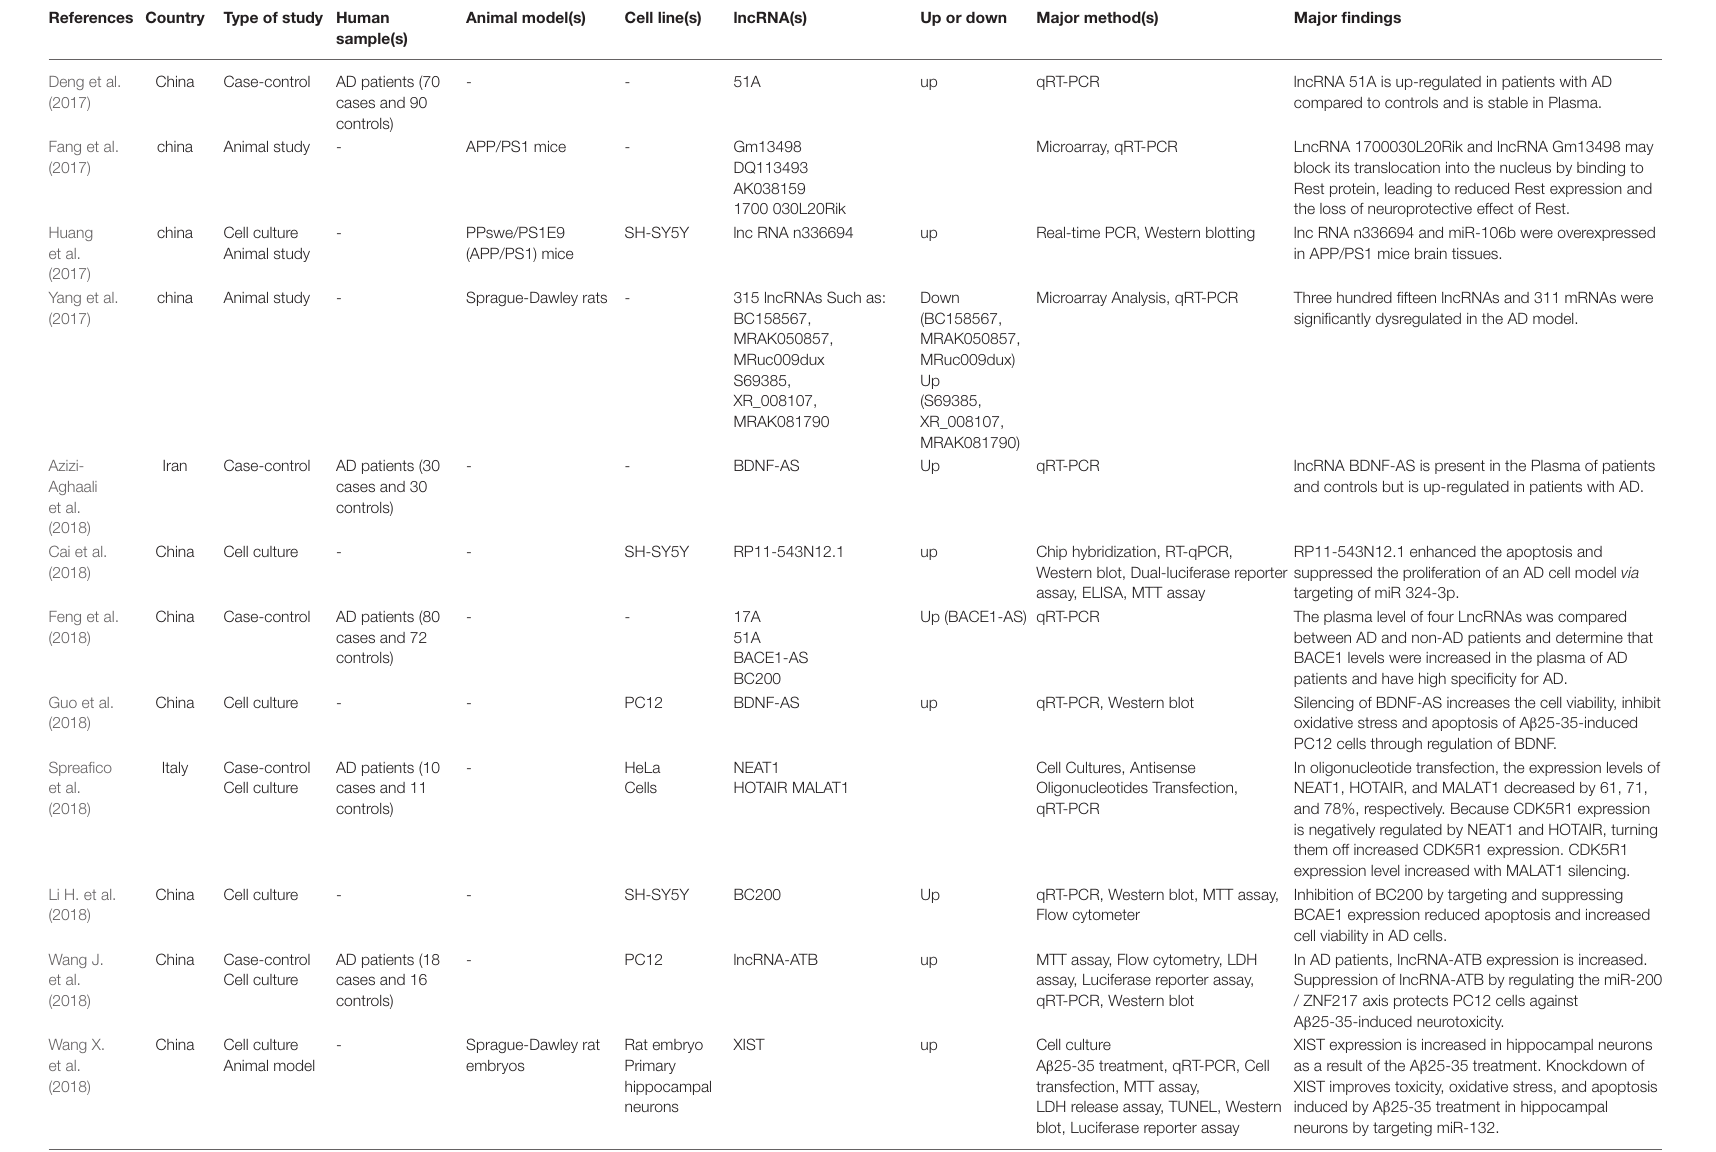
neurons by targeting